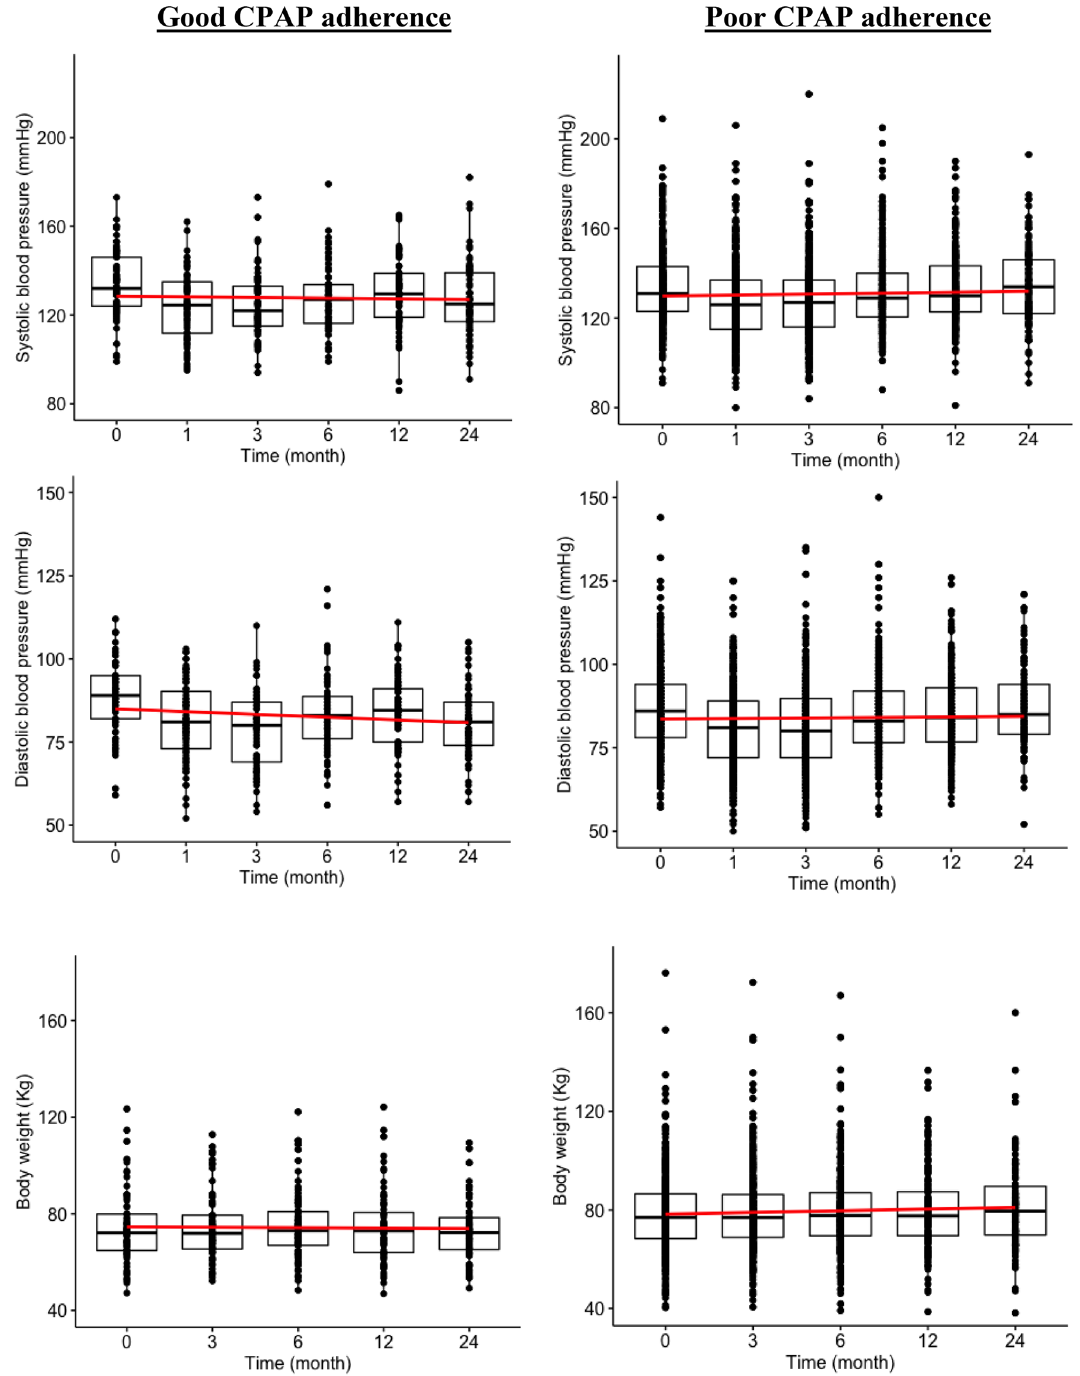
Figure 3. Association between longitudinal changes in blood pressure and body weight and adherence of continuous positive airway pressure. The red lines are temporal trends of mean blood pressure derived using linear regression functions. Good CPAP adherence, using CPAP for more than 4 h ≥ 70% of the time of the 30 days prior to all follow-up points.; Poor CPAP adherence, using CPAP for more than 4 h ≤ 70% of the time of the 30 days prior to all follow-up points. Time, month of CPAP treatment. Model was adjusting for age, sex, alcohol consumption, smoking, medication history of hypertension, medication history of diabetes, medication history of dyslipidemia, body weight, and Epworth Sleepiness